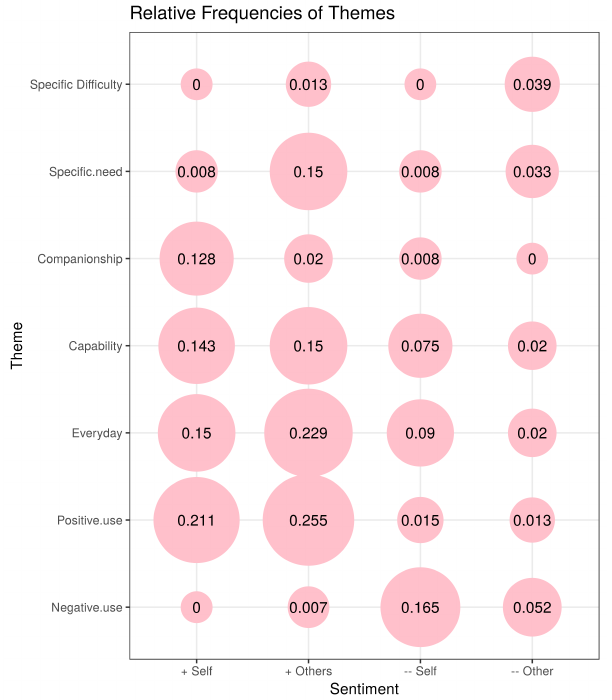
Figure 11: Relative frequencies of Themes referenced when dis- cussing Sentiments by Category.